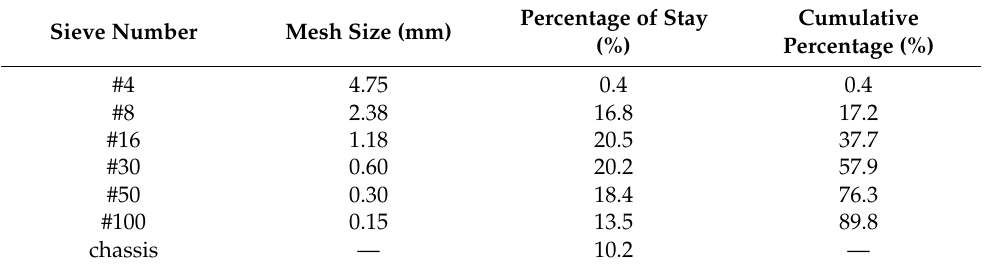
Table 4. Gradation distribution of natural fine aggregate.